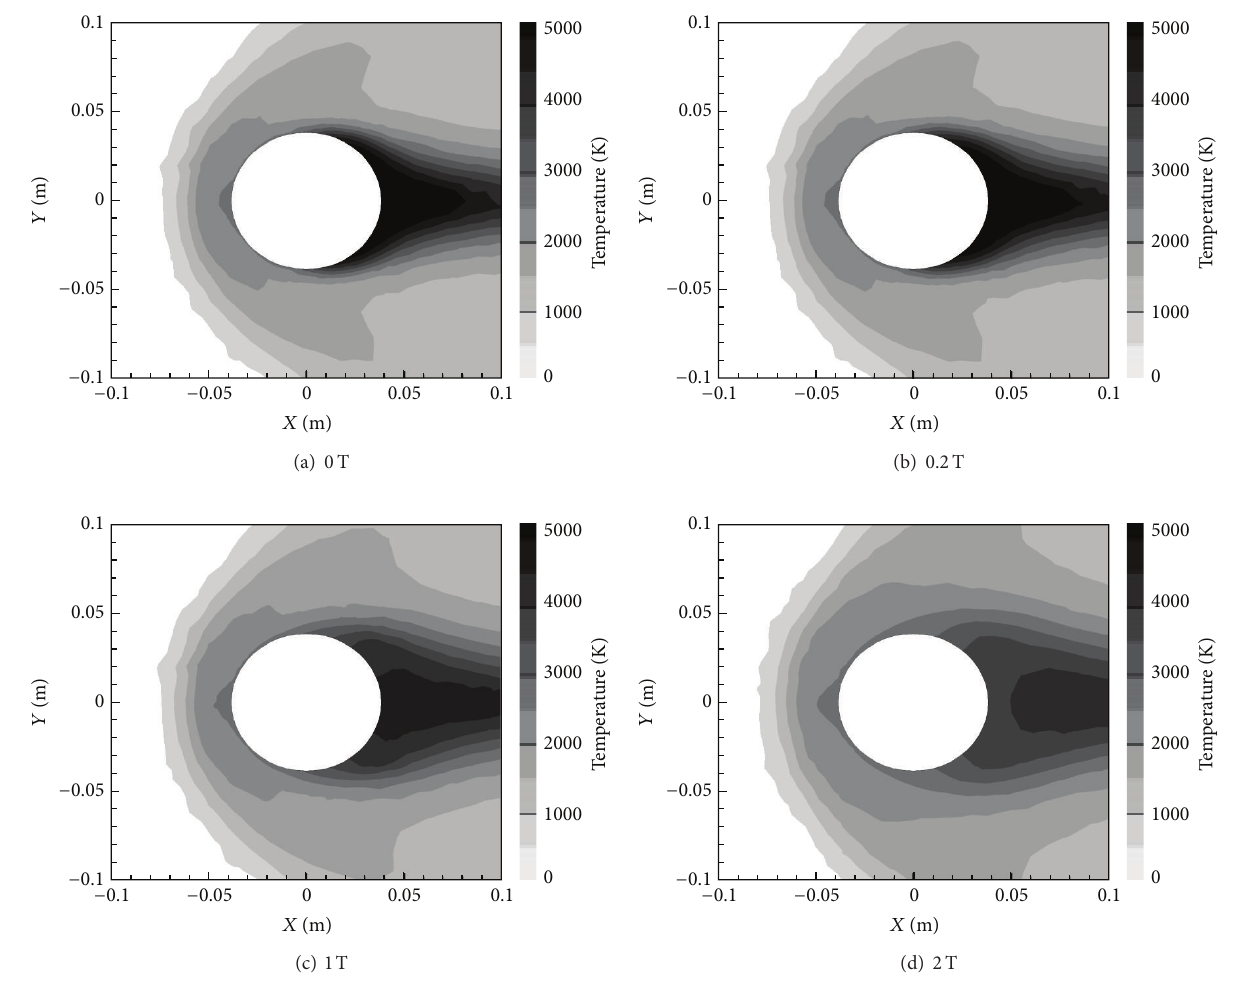
Figure 15: Temperature contours for various 𝐵 max with 𝑌